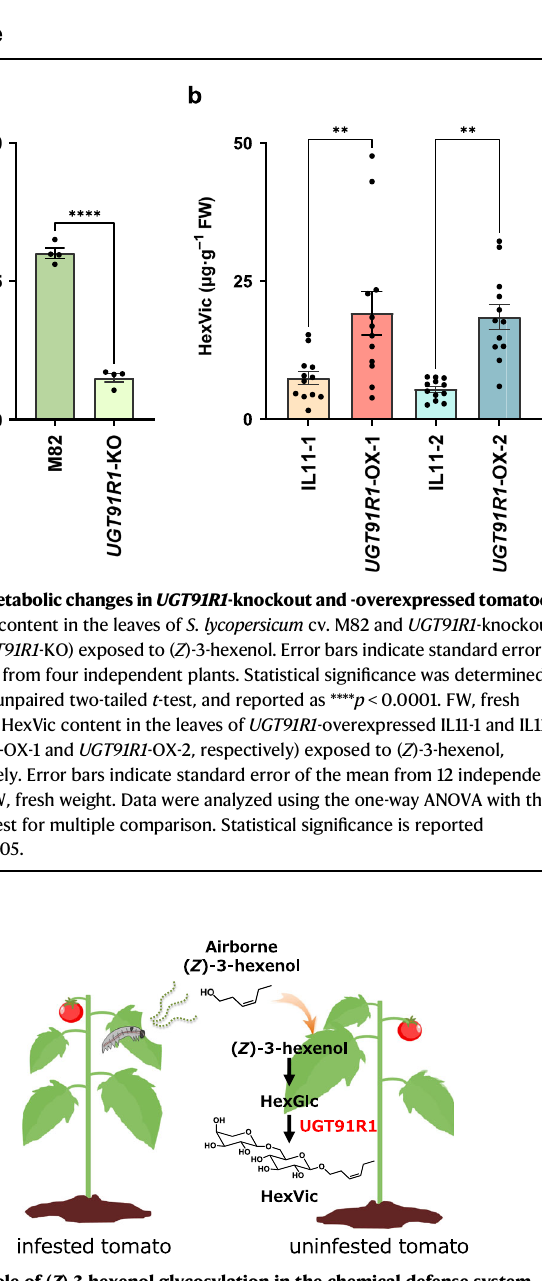
Fig. 5 | Role of ( Z )-3-hexenol glycosylation in the chemical defense system against herbivory. Schematic representation of the roles of ( Z )-3-hexenol glyco- sylation in the distal/future defense against